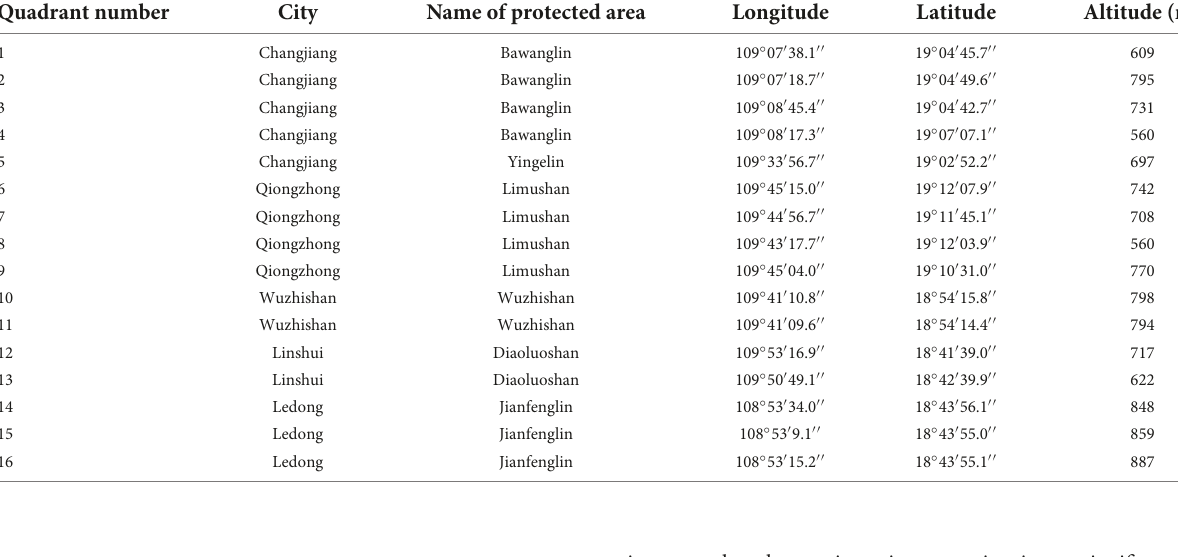
TABLE 1 Basic status of Hopea hainanensis populations in Hainan